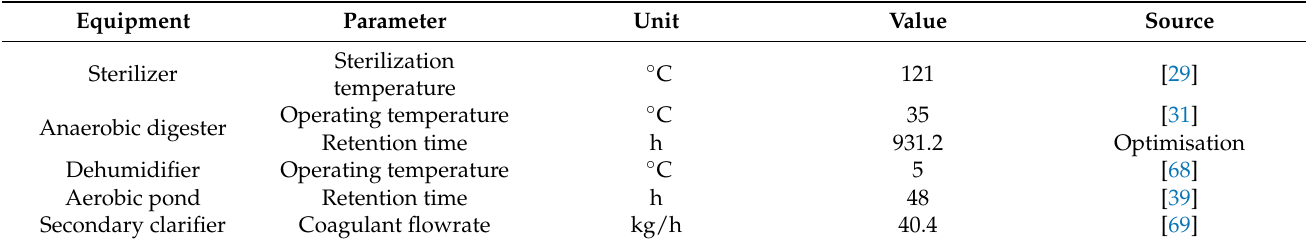
Table A2. Equipment specifications.